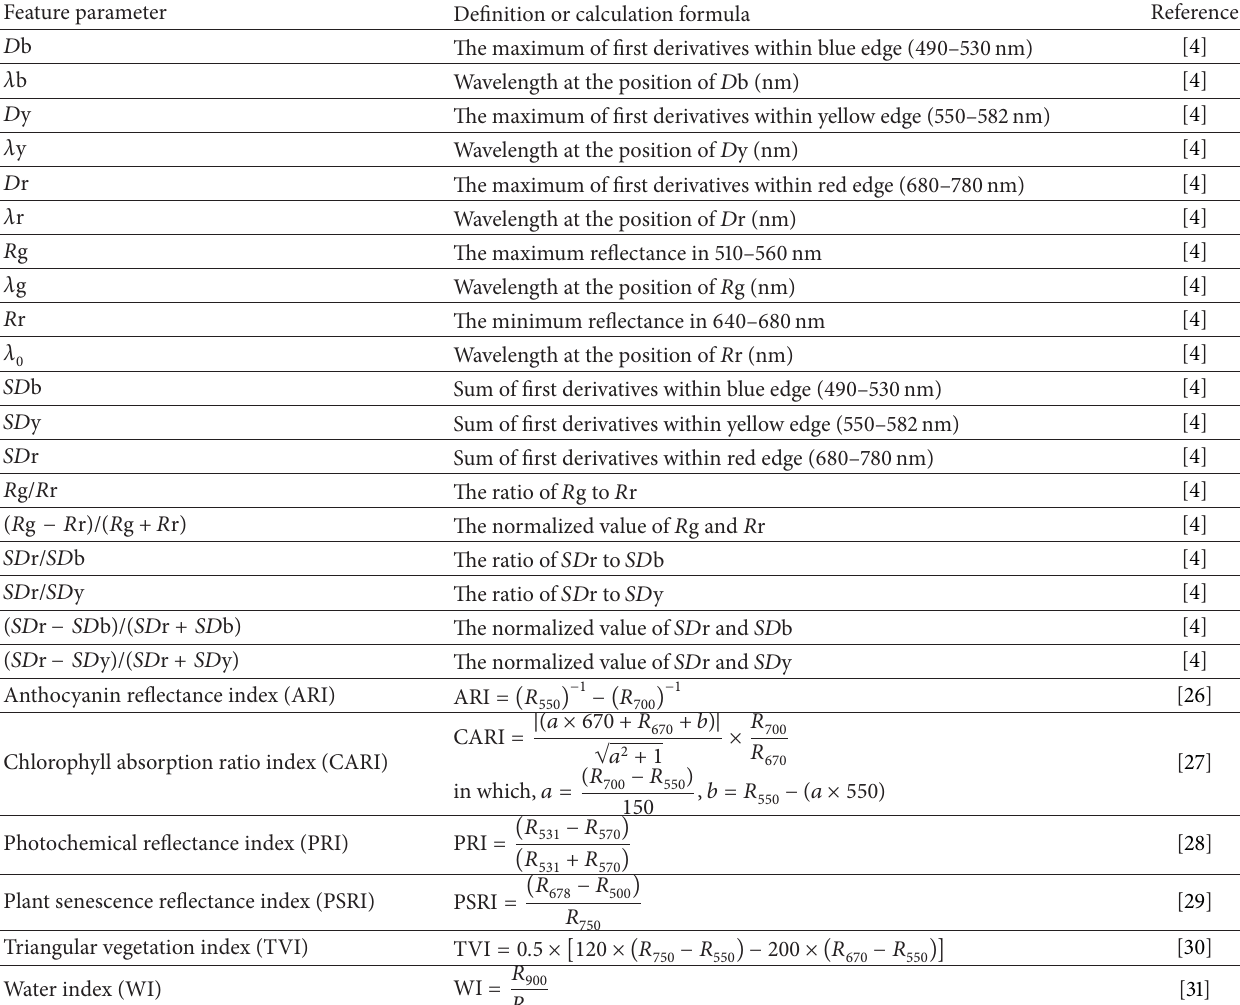
Table 1: The feature parameters in the third group of spectral